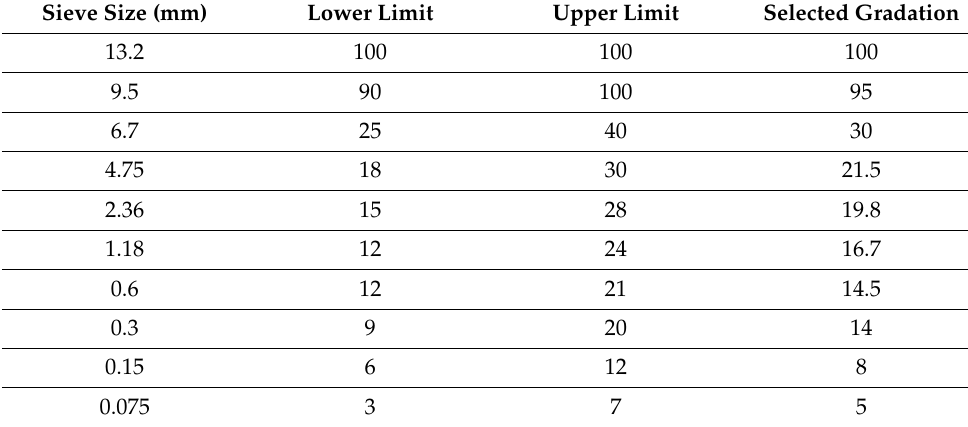
Table 3. Particle-size distribution of stone mastic